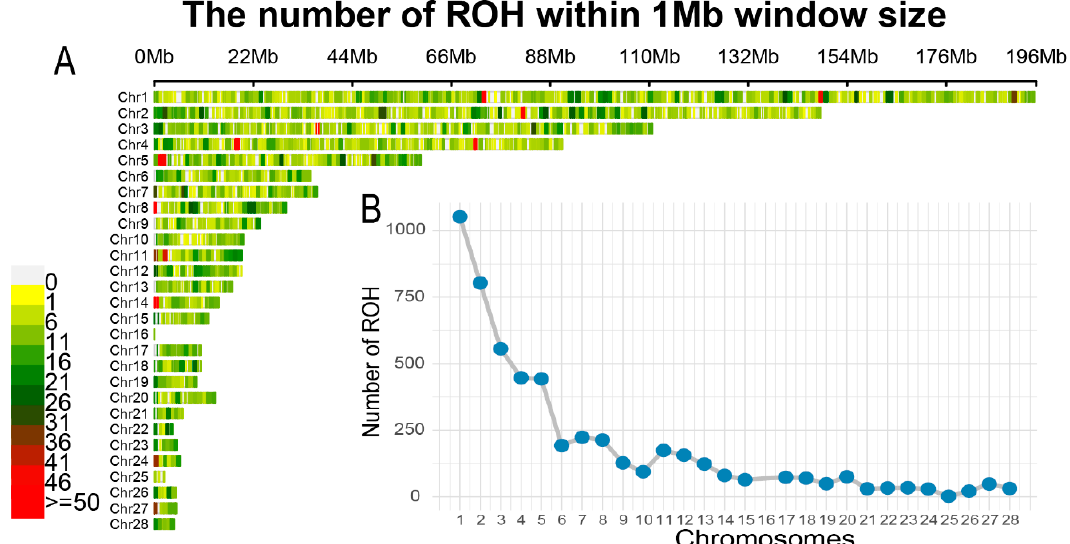
Figure 4. ( A ) Number of ROH within 1 Mb window and ( B ) number of ROH on each chromo- some. Table 2. Statistics of ROH.